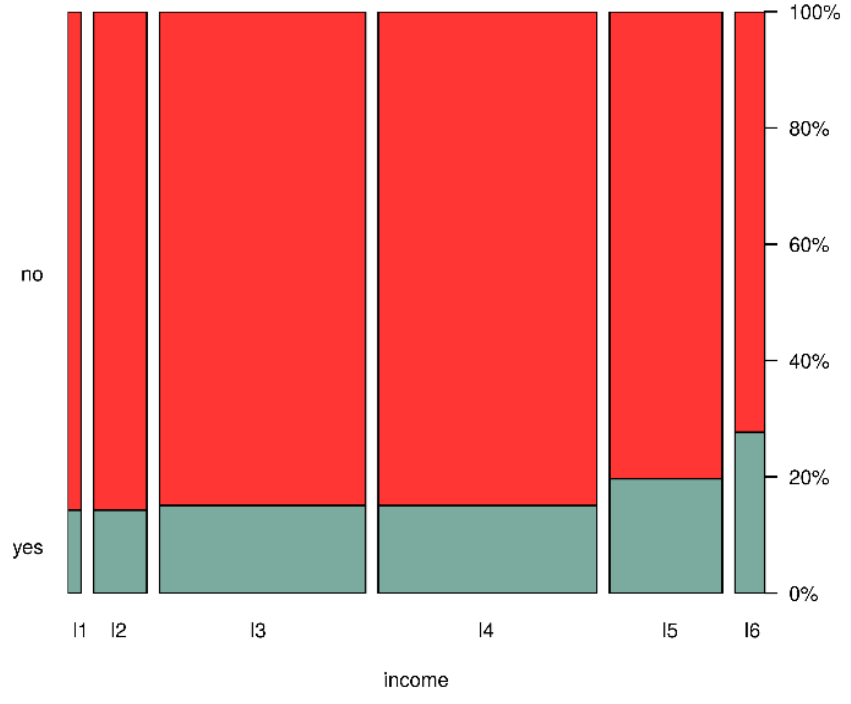
Figure 10. Declaration on the use of RES by income.